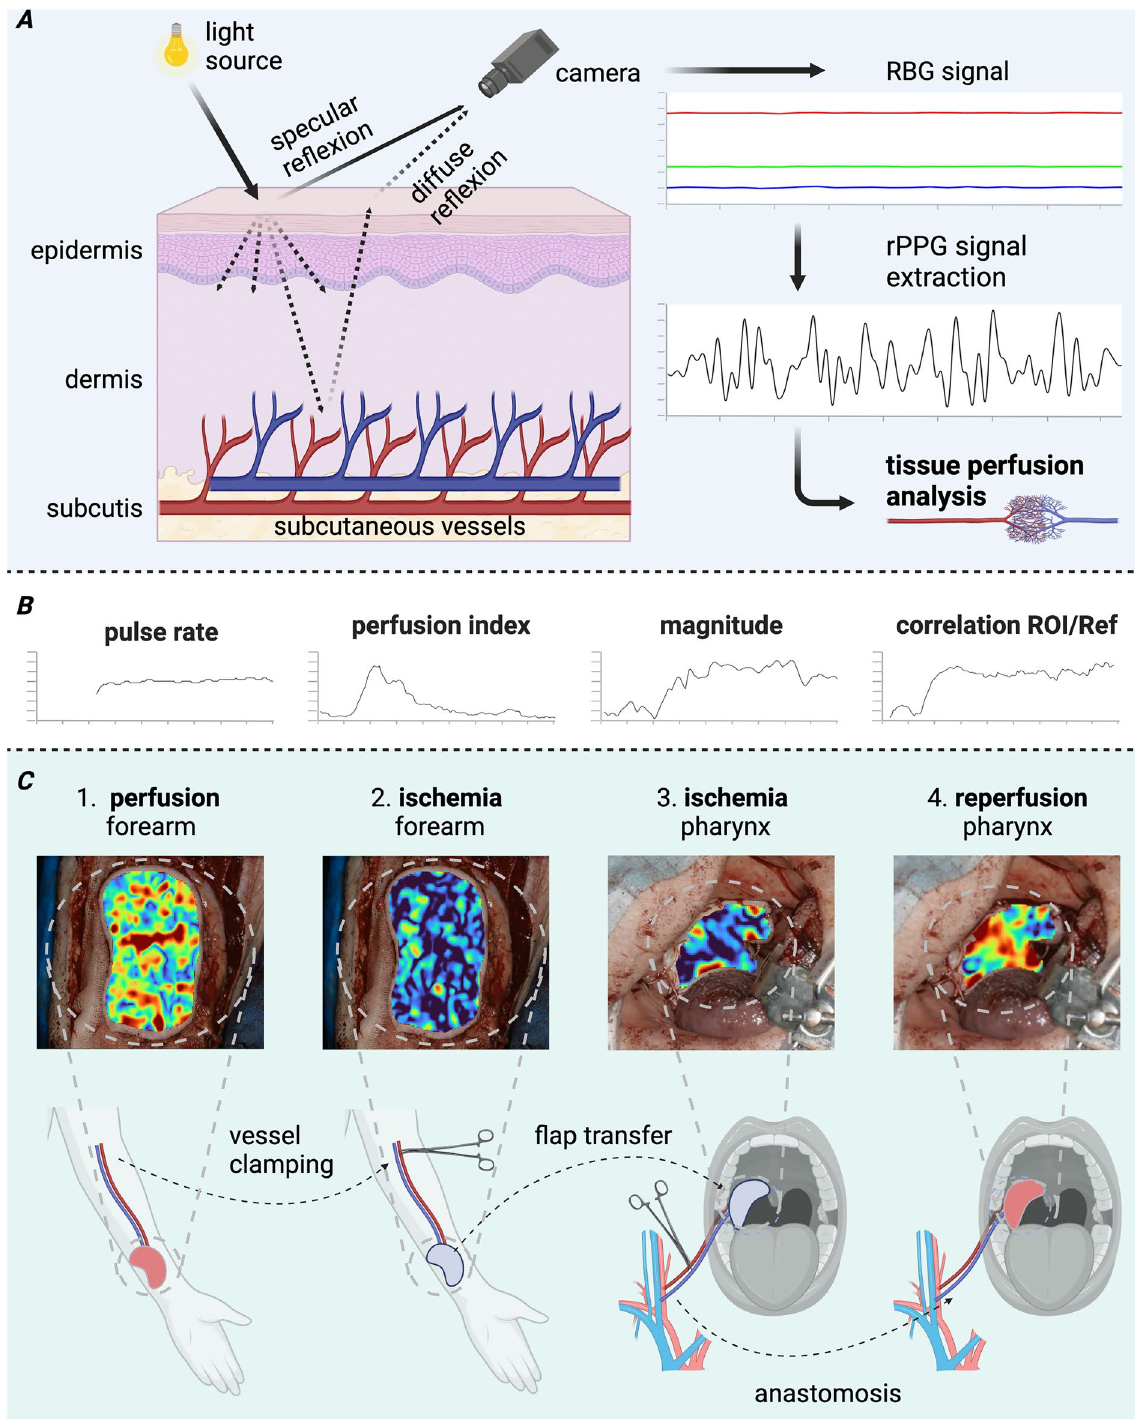
Figure 1. Intraoperative flap monitoring. ( A ) Method of remote photoplethysmography (rPPG) using the continuously captured RGB signal to extract the rPPG signal and analyze tissue perfusion. ( B ) The proposed parameter for flap perfusion monitoring. ( C ) The study setup with 1. monitoring of healthy well-perfused forearm area, 2. monitoring of prepared flap at forearm at the beginning of ischemia, 3. monitoring transferred flap at pharynx still non-perfused until 4. reperfusion. The visualization of the determined perfusion parameter allows a continuous intraoperative flap monitoring, here shown for #9 using parameter magnitude for all four analyzed time